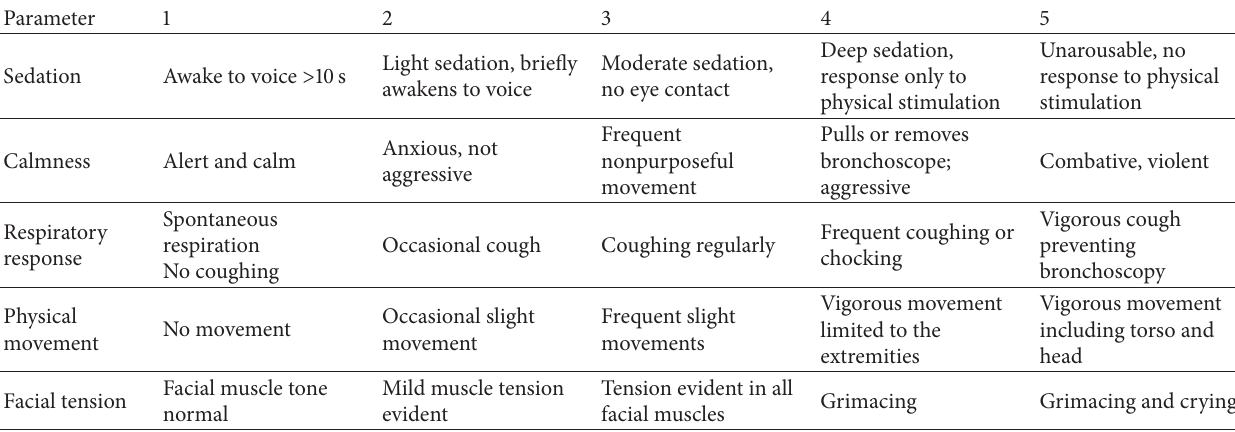
Table 1: Composite score during bronchoscopy (5–25).